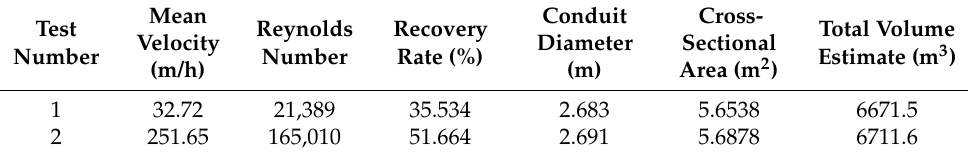
Table 2. Results of tracer tests.